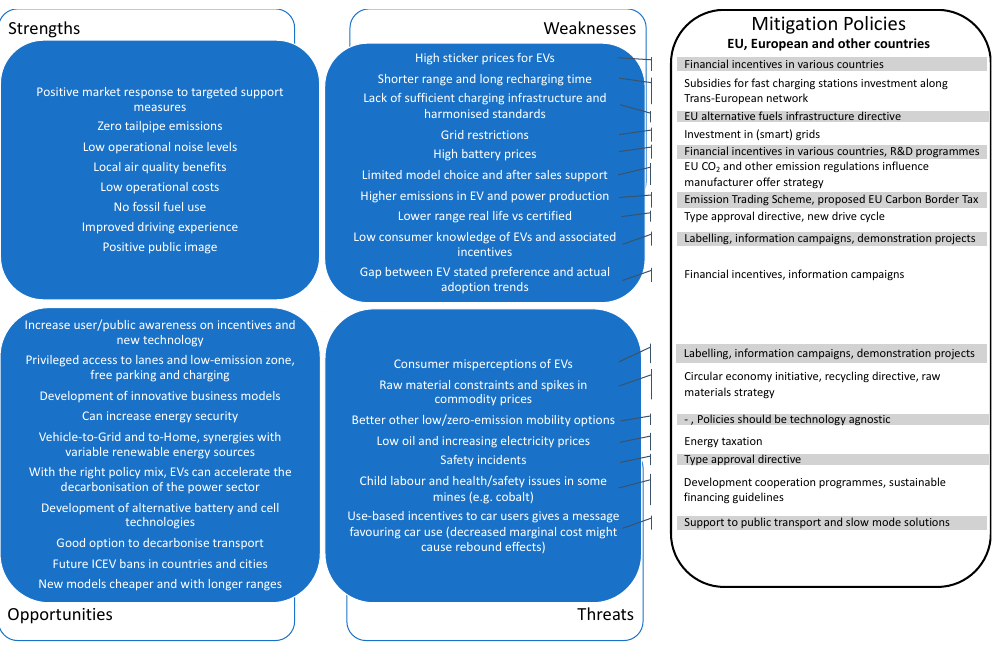
Figure 2. Strengths, Weaknesses, Opportunities, Threats (SWOT) analysis of electric vehicles (EVs) vs. internal combustion engine vehicles (ICEVs) and support policies mitigating the weaknesses and threats, adapted from [41].